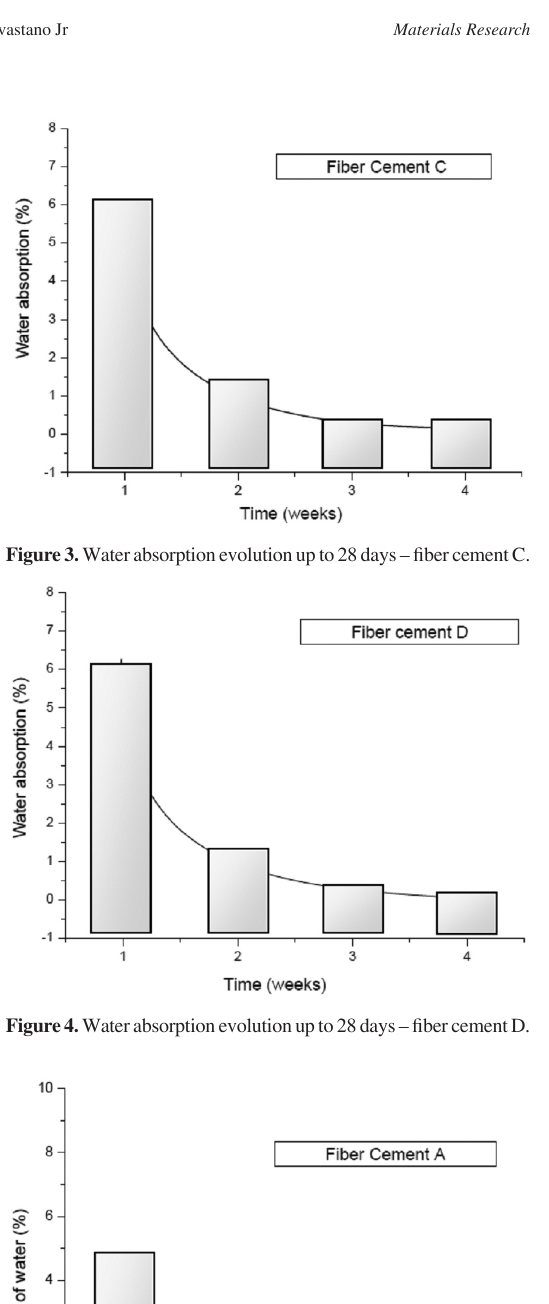
Figure 2. Water absorption evolution up to 28 days – fiber cement B.